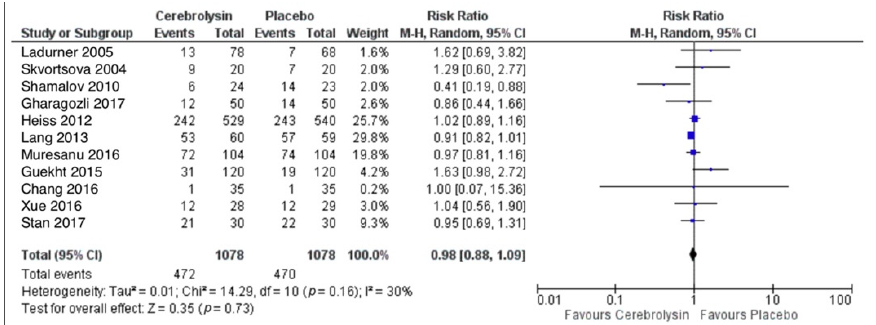
Figure 4. Adverse events (patients with at least one AE); Comparison of Cerebrolysin versus Placebo in the Safety Population, Random Effects, M-H, Risk Ratio (RR).